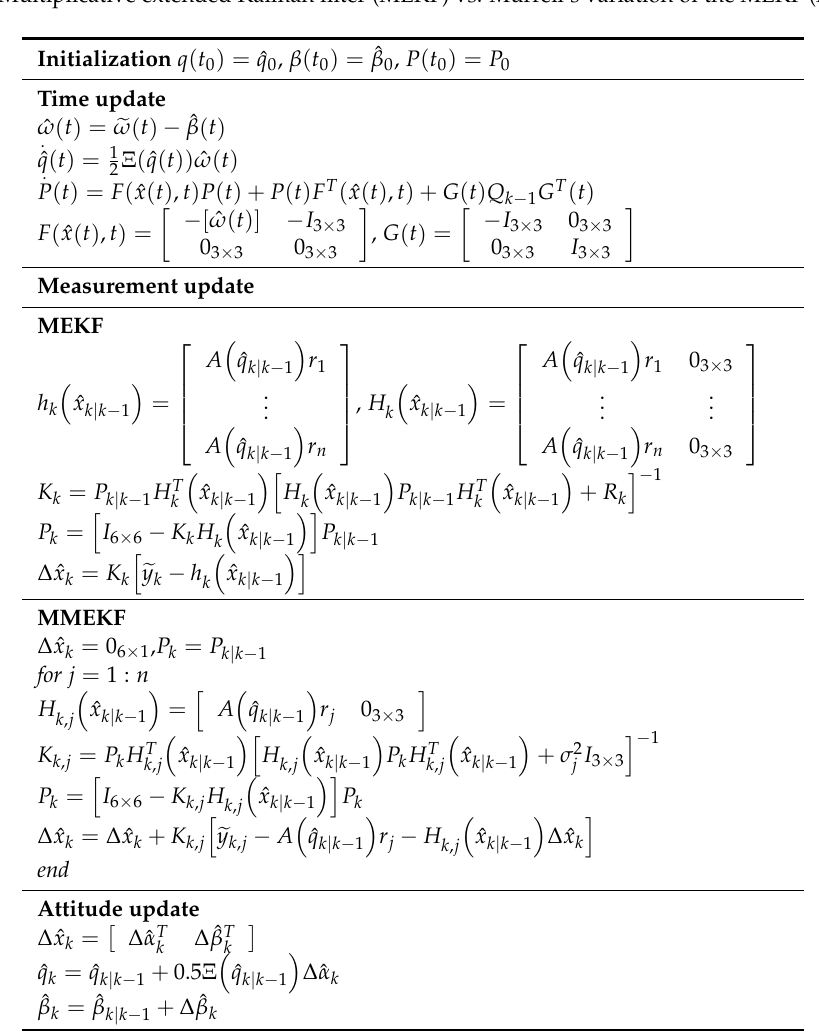
Table 1. Multiplicative extended Kalman filter (MEKF) vs. Murrell’s variation of the MEKF